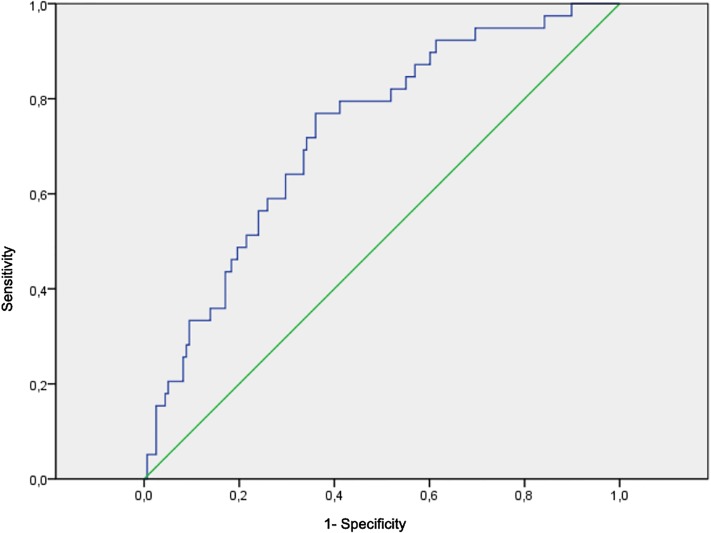
ROC curve of the final model.Nagelkerke r2: 0.16. ROC AUC: 0.726 (0.642–0.811) P<0.001.